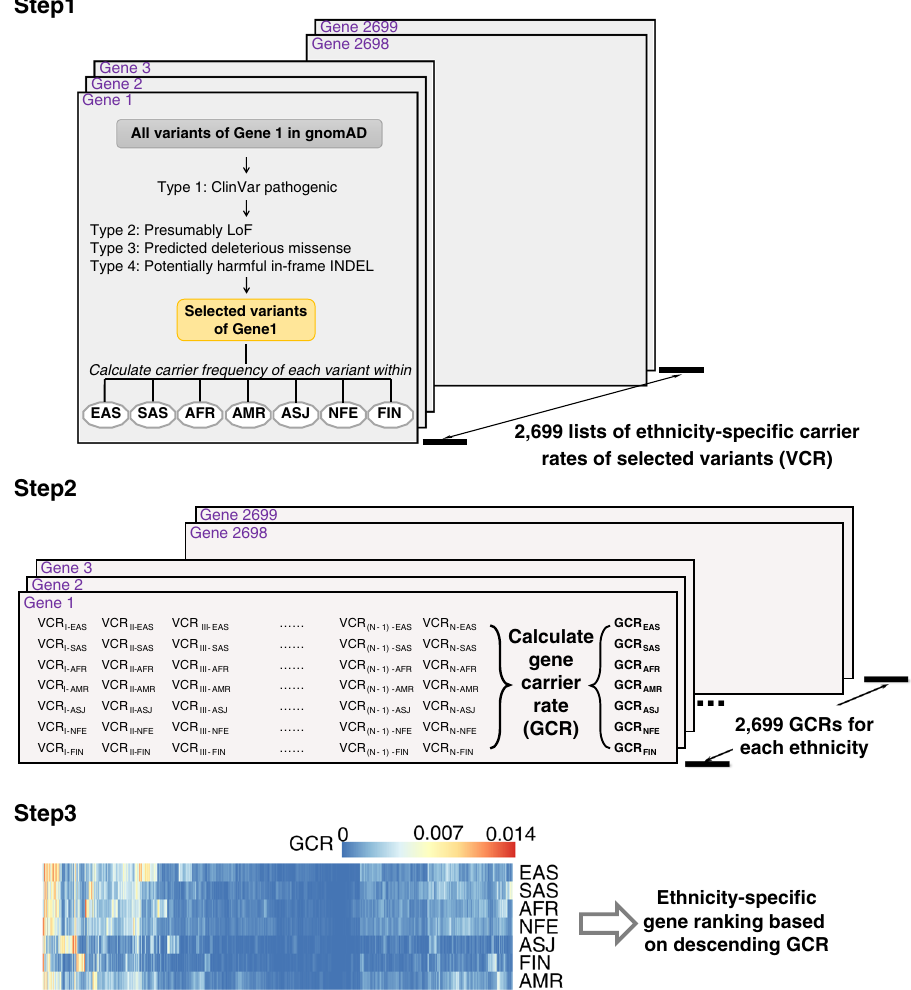
Fig. 1 Analysis work fl ow of ranking carrier frequencies in all recessive genes. Steps in the discovery (gnomAD) cohort are illustrated. EAS East Asian, SAS South Asian, AFR African/African American, AMR Latino/Admixed American, ASJ Ashkenazi Jewish, NFE European (non- Finnish), FIN European (Finnish), VCR variant carrier rate, GCR gene carrier